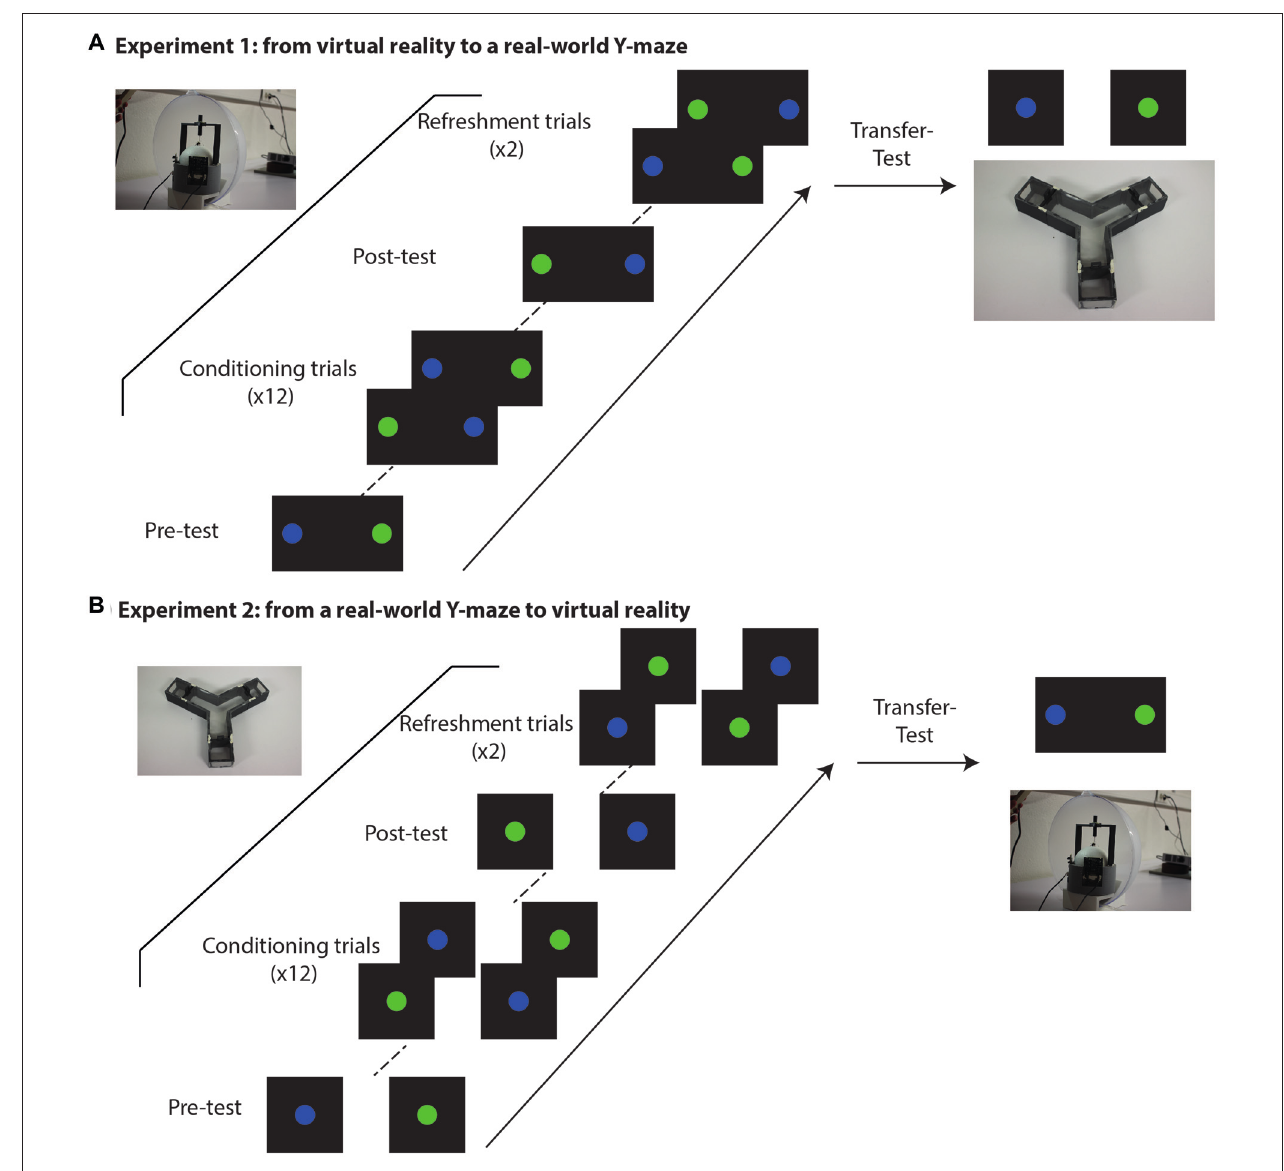
FIGURE 2 | Experimental schedule at the VR setup (A) and at the Y-maze (B) . (A) Experimental sequence of Experiment 1. Bees started with a pre-test in which both colored discs were shown in the absence of reinforcement to check for spontaneous preferences and determine the CS+ (the color less preferred) and the CS − (the color more preferred) for the conditioning procedure. The pre-test was followed by 12 conditioning trials in which both colored discs were shown simultaneously and associated with sucrose solution (CS+) or quinine solution (CS − ). After conditioning, a post-test in which both stimuli were shown simultaneously without reinforcement allowed to determine whether bees learned the visual discrimination. Two refreshment trials with reinforcement were performed after the post-test and before the transfer to the Y-maze to avoid extinction of the learned information. Pre-test, conditioning and post-test were performed in closed-loop conditions, i.e., the movements of the bee controlled the visual cues displayed on the screen in front of it. After the post-test, bees were transferred to the Y-maze in which both stimuli were presented in different arms of the maze. Bees were tested for transfer of discrimination learning to this new context. (B) Experimental sequence of Experiment 2. The schedule was similar to that of Experiment 1 with the difference that pre-test, training and post-test took place in the Y-maze where the bee movements were not constrained. Colored discs were presented on the article walls at the end of the maze arms. After the post-test, bees were transferred to the VR setup where they could see both colored discs